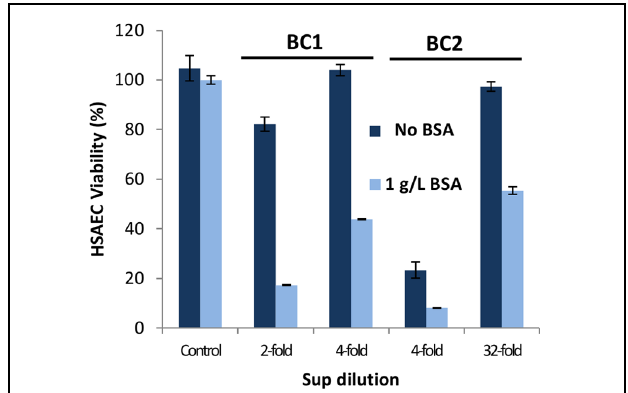
FIGURE 4 | The cultivation of B. cereus in medium supplemented with BSA enhances the cytotoxicity of Sups. DMEM was supplemented with or without 1 g L − 1 of BSA and Sups were generated from 20-h microaerobic cultures. Dilutions were prepared with the medium used for growing cultures and their toxicity to HSAECs assessed in triplicates using resazurin.